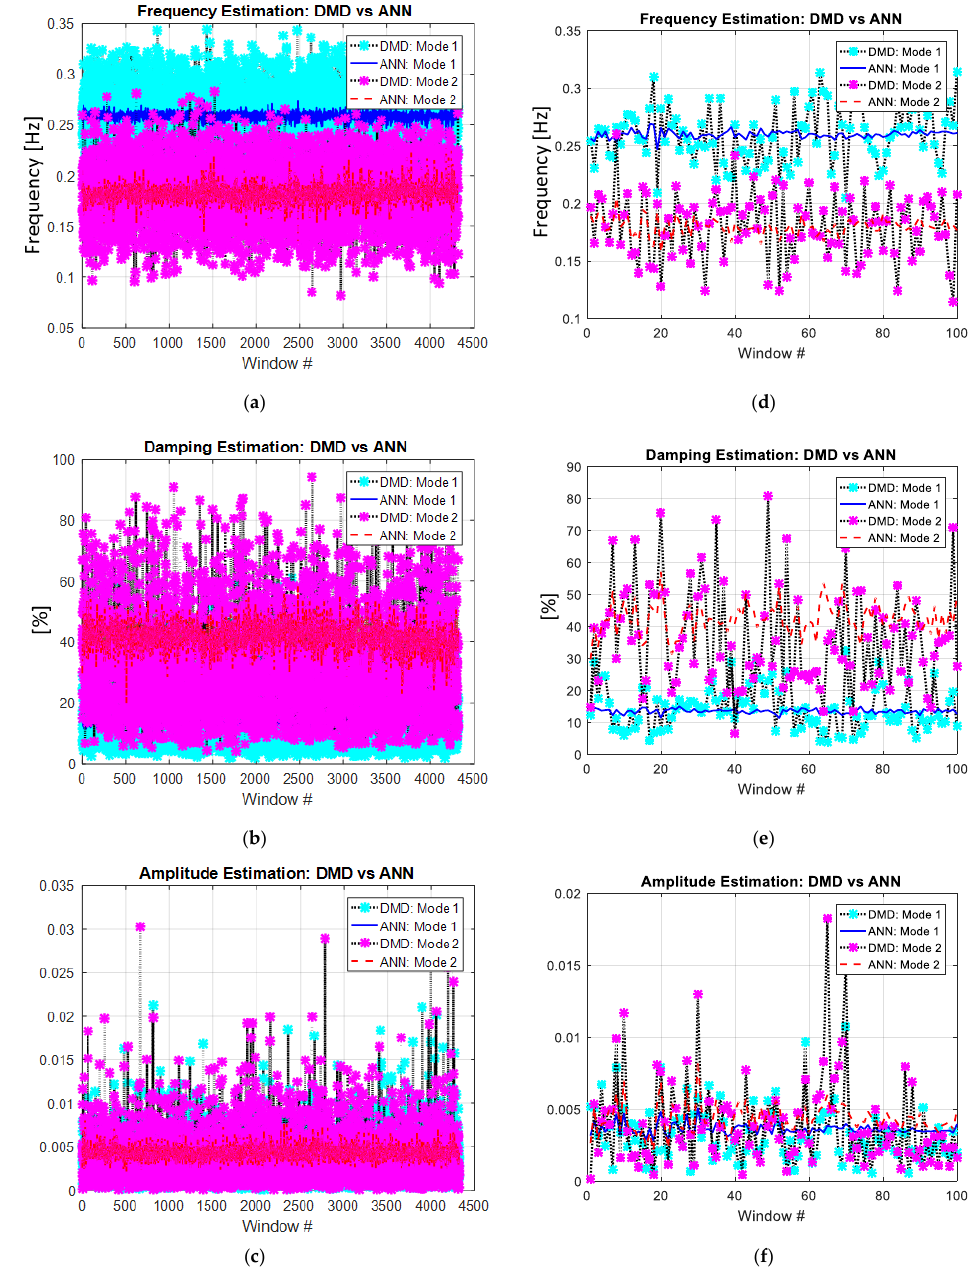
Figure 7. Comparison of the estimates produced by DMD versus the estimates produced by the ANN approach for the case of Dataset DS3: ( a , d ) frequency; ( b , e ) damping, ( c , f ) amplitude.